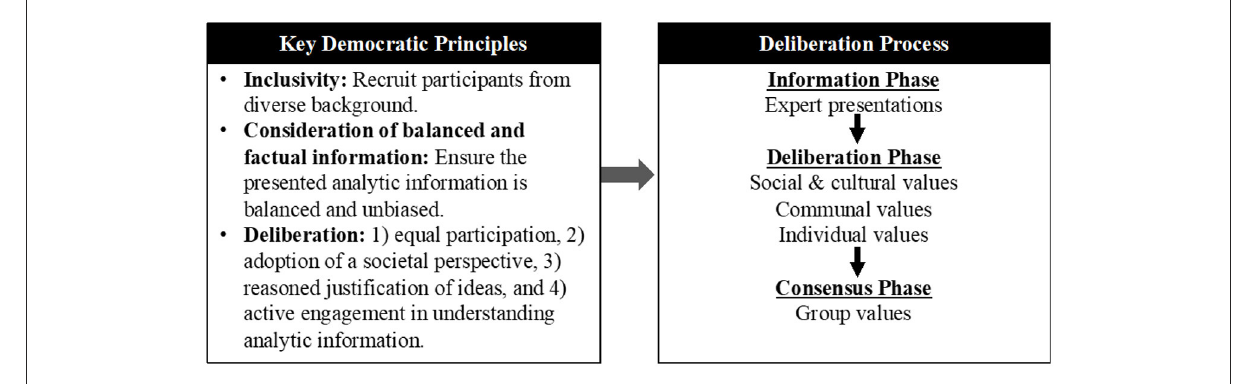
FIGURE1 Conceptual framework of democratic deliberation